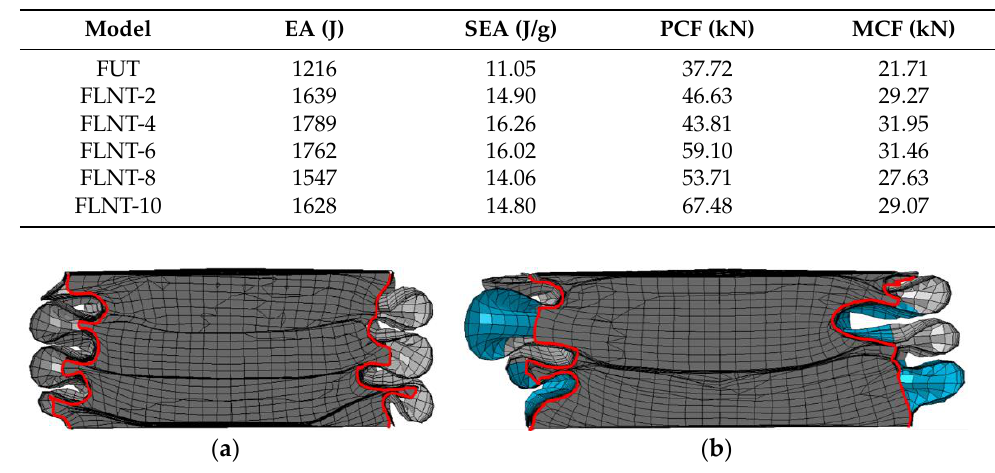
Figure 17. Comparison of densification effect: ( a ) FUT and ( b ) FLNT-4.